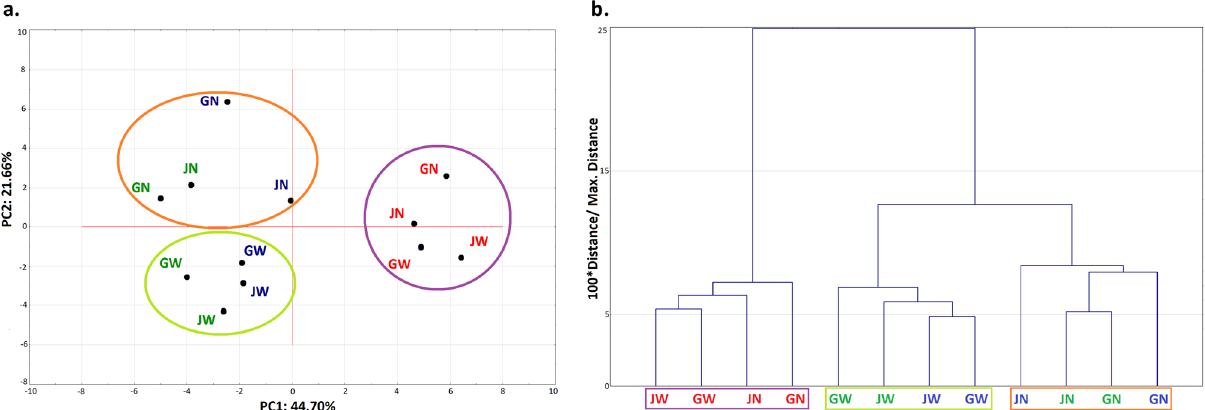
Figure 4. PCA analysis for VOCs and cupping for the roasted coffees. ( a ) Projection of factors on the plane. ( b ) Tree diagram. The font in color blue refers to storage in (– 10 °C), green- 10 °C, and red- 20 °C chambers in time of storage (Statistica, ver. 10, StatSoft).